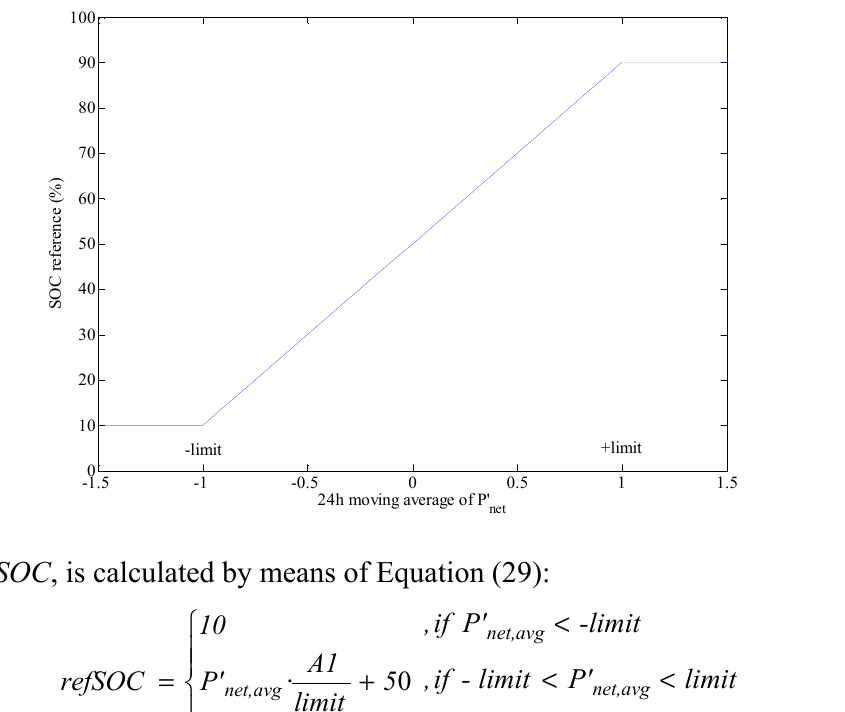
Figure 16. Variation of refSOC with the moving average of P'